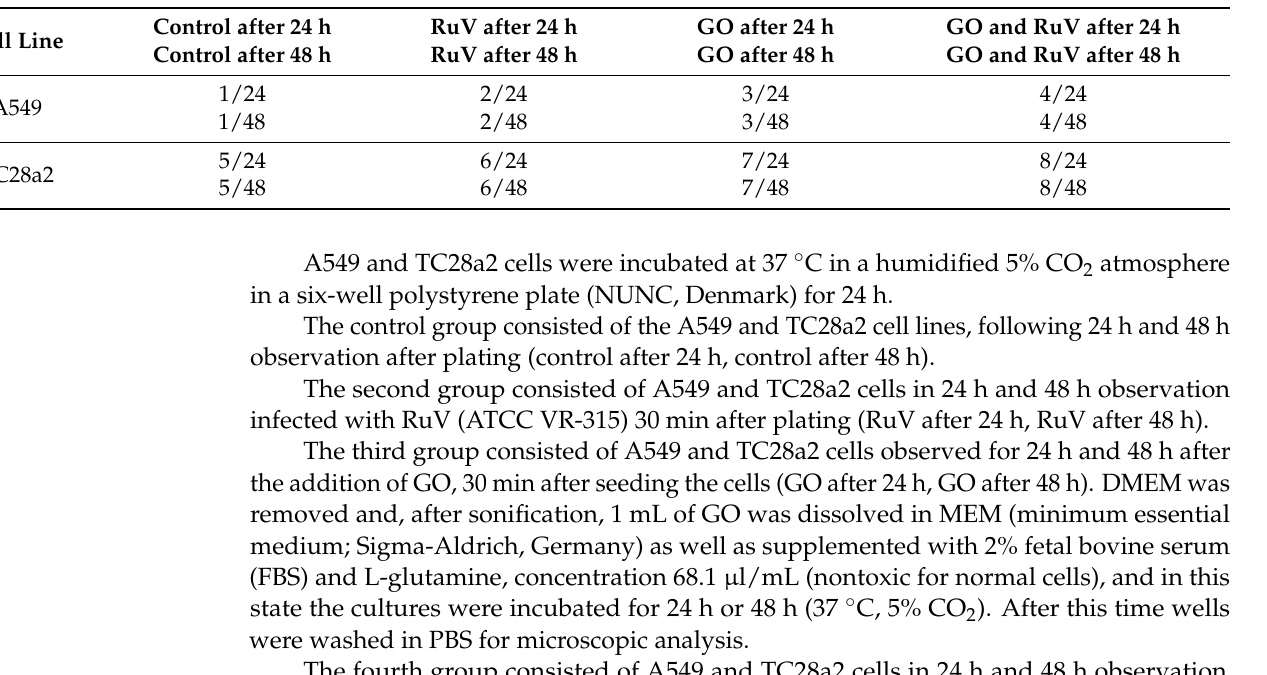
Table 1. Group names according to the cell line types, GO and RuV administration and time of observation used in